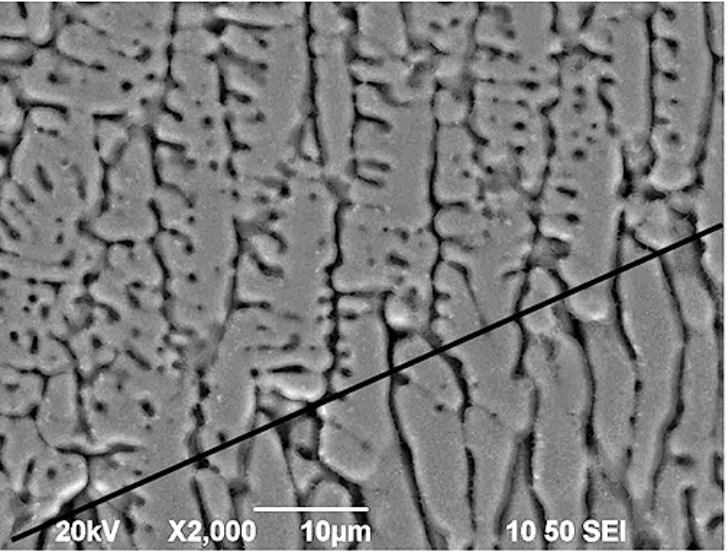
Figure 19. SEM micrograph revealing the morphologies on the both side of the re-melted boundary between 1st and 2nd layers of the AlCoCrCuFeNi HEA coating (denoted by the line). Reprinted with permission from Ref. [94]. Copyright 2019 Elsevier.